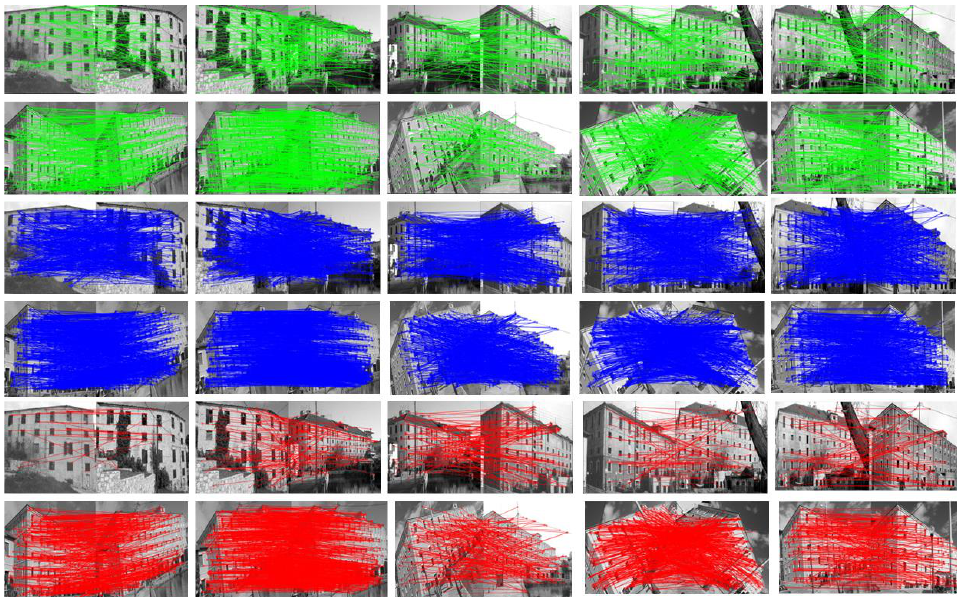
Figure 16. Tobacco industry building. Feature matching historic buildings over time. Green, blue, and red matches are by SIFT, ORB, and BRISK algorithms, respectively.